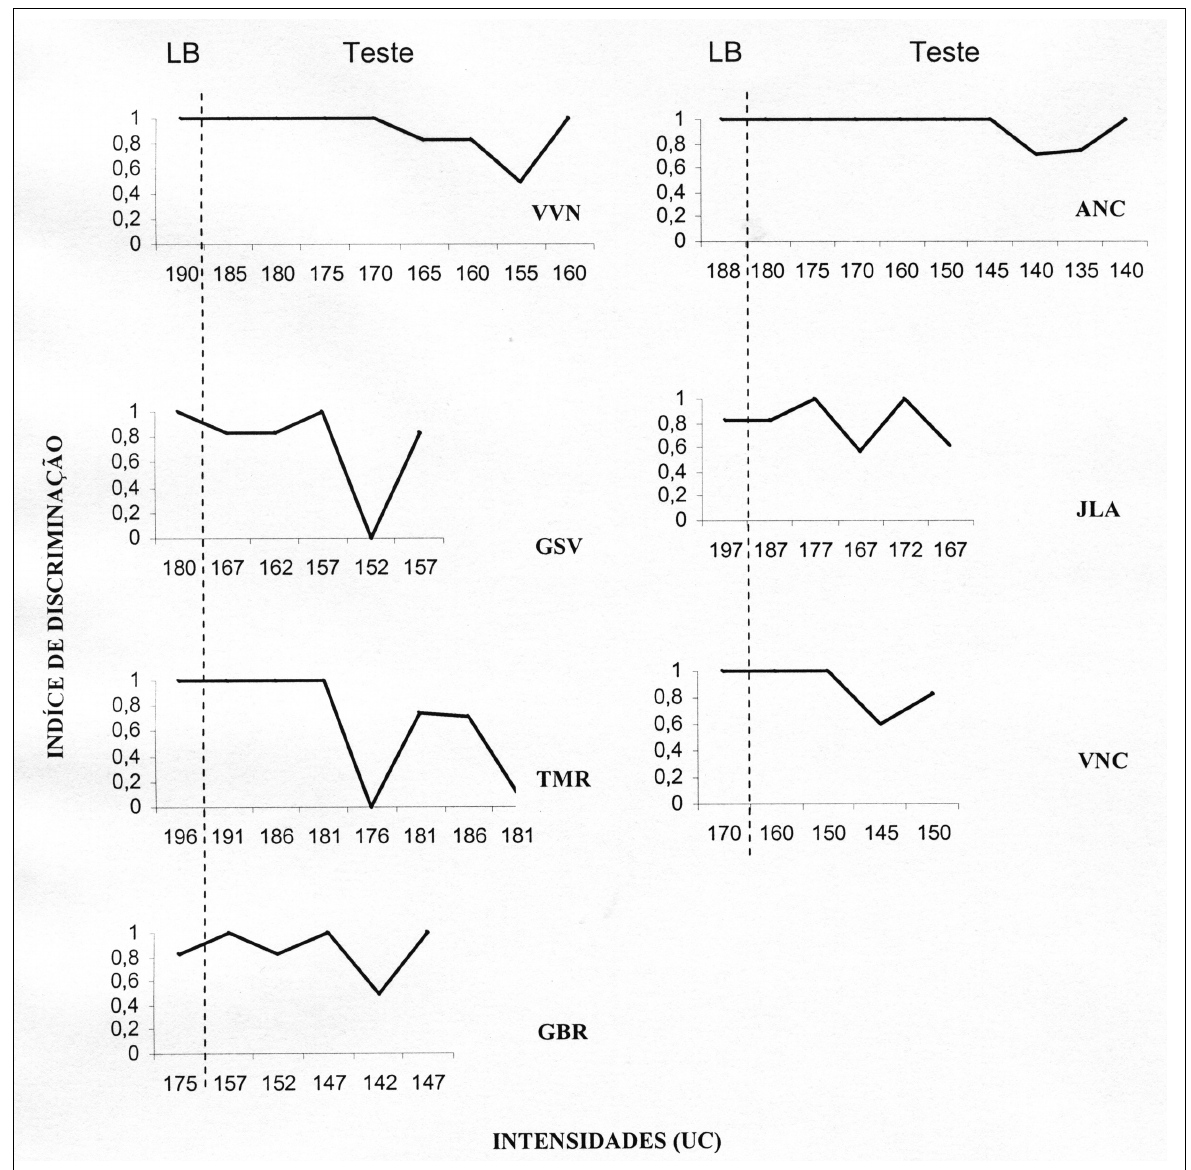
Figura 3 . Índice de discriminação na avaliação de linha de base (LB) e ao longo da seqüência de intensidades manipuladas em blocos de 10 tentativas na fase de